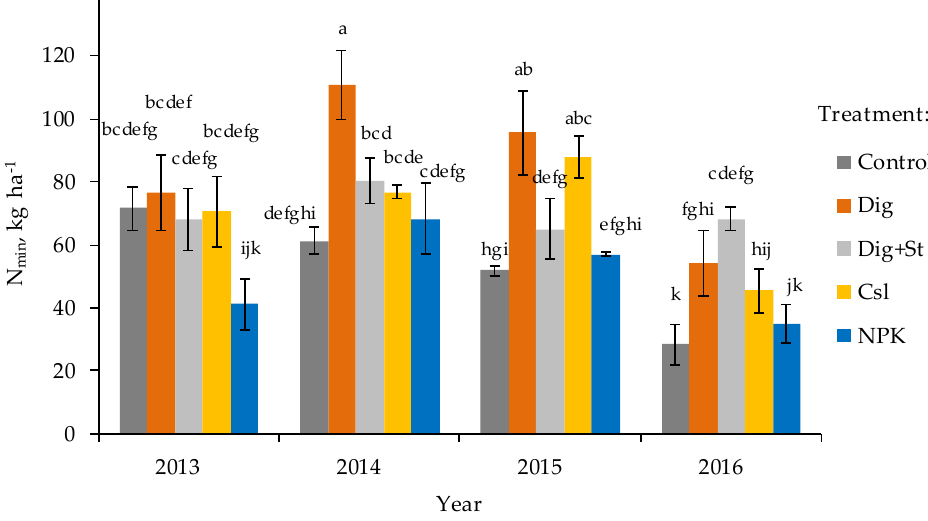
Figure 1. Mineral nitrogen content in 0.0–0.60 m soil depth (total N min ) in spring (before applying mineral N fertilizers) depending on the interaction between year and fertilizer treatment. Different letters indicate statistically significant differences between treatments (HSD test). Hatched bars represent 2 × SEM ranges.